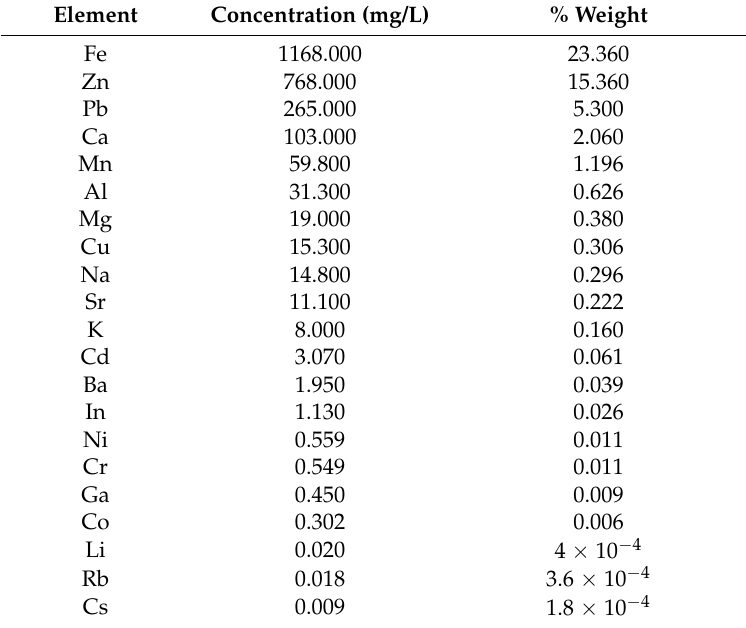
Table 2. ICP-MS data: Concentrations of the elements of a solution containing 0.5 g zinc ferrite (Section